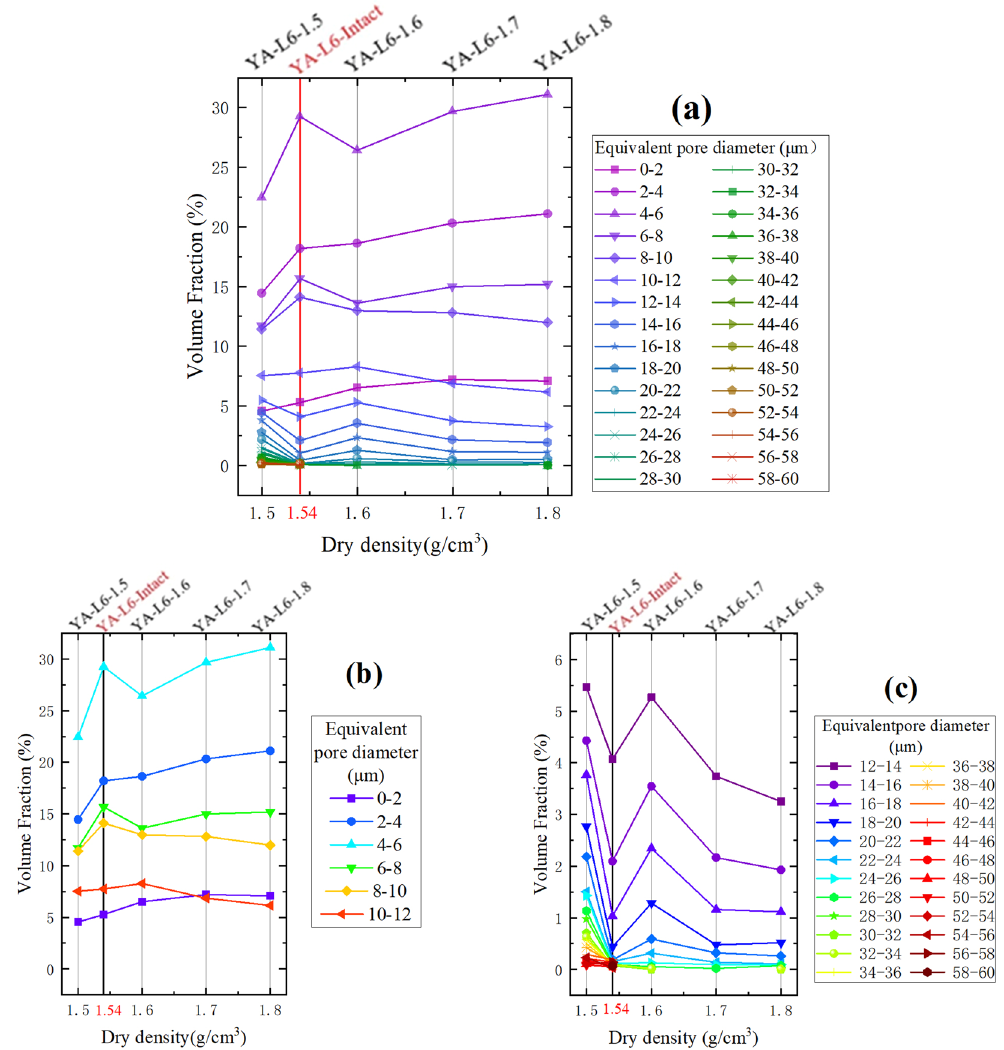
Figure 4. Volume fraction obtained from CT scanning for different equivalent pore diameter vs. dry density of the intact and compacted loess samples: ( a ) pores with an equivalent diameter of 0~60 μ m; ( b ) pores with an equivalent diameter of 0~12 μ m shown in ( a ); ( c ) pores with an equivalent diameter of 12~60 μ m shown in ( a